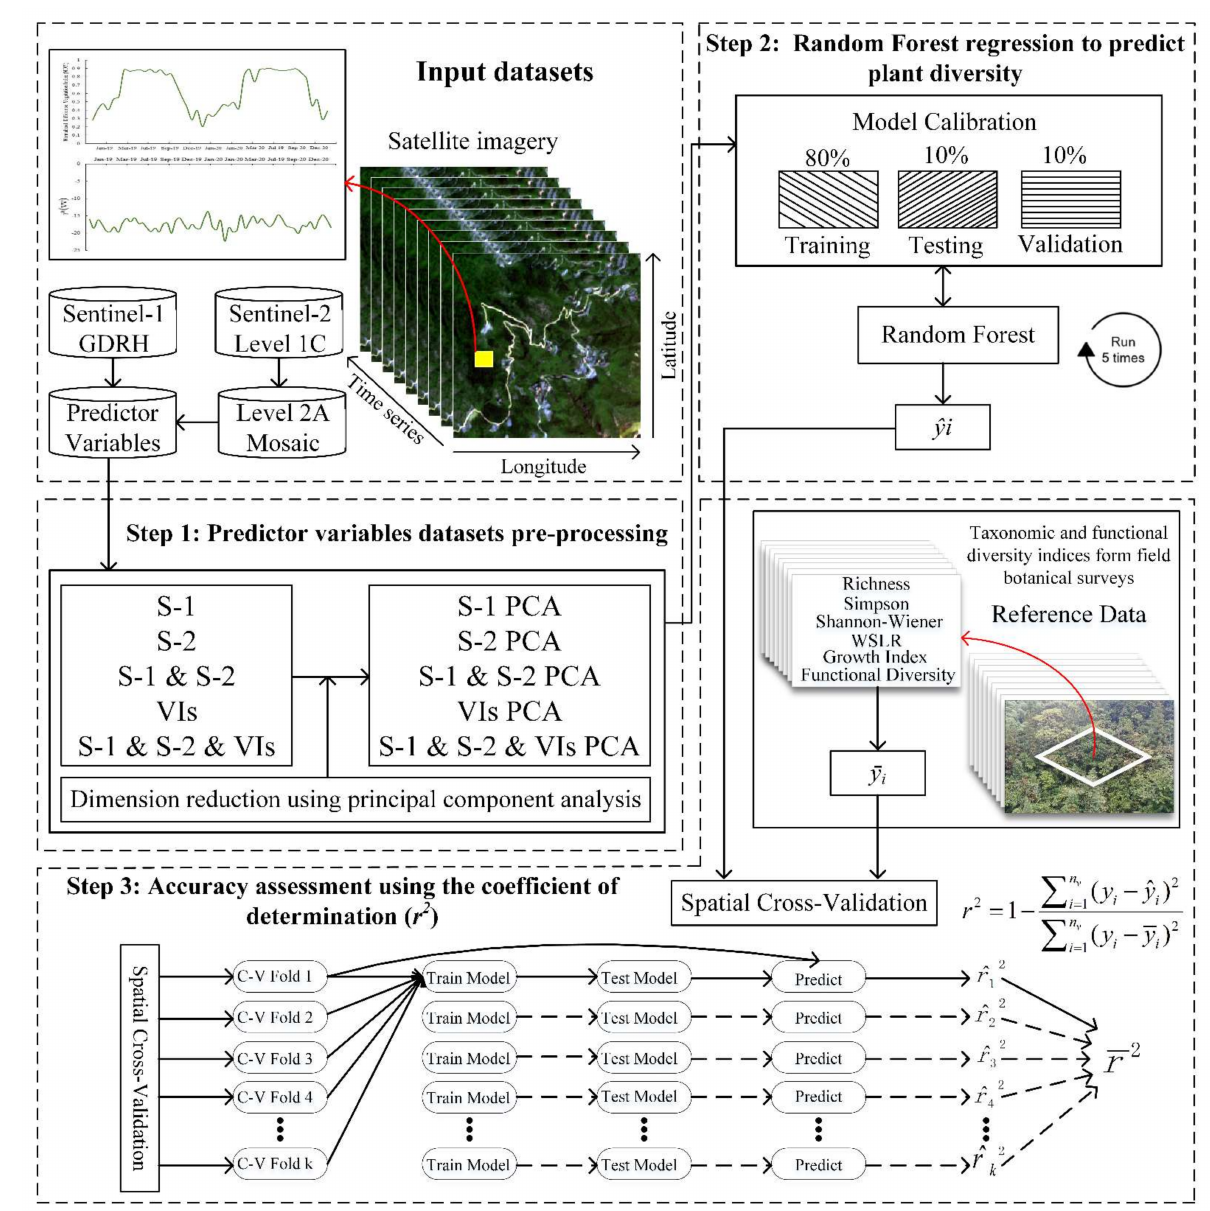
Figure 1. Flowchart of the proposed method. S-1, Sentinel-1; S-2, Sentinel-2; VIs, vegetation